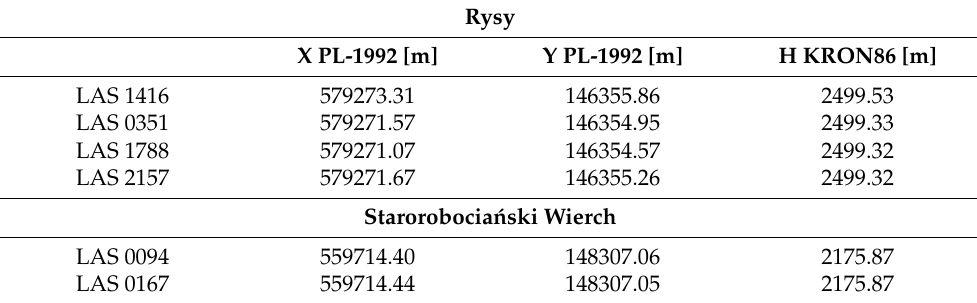
Table 2. The highest points in Slovak ALS datasets classified as Ground.